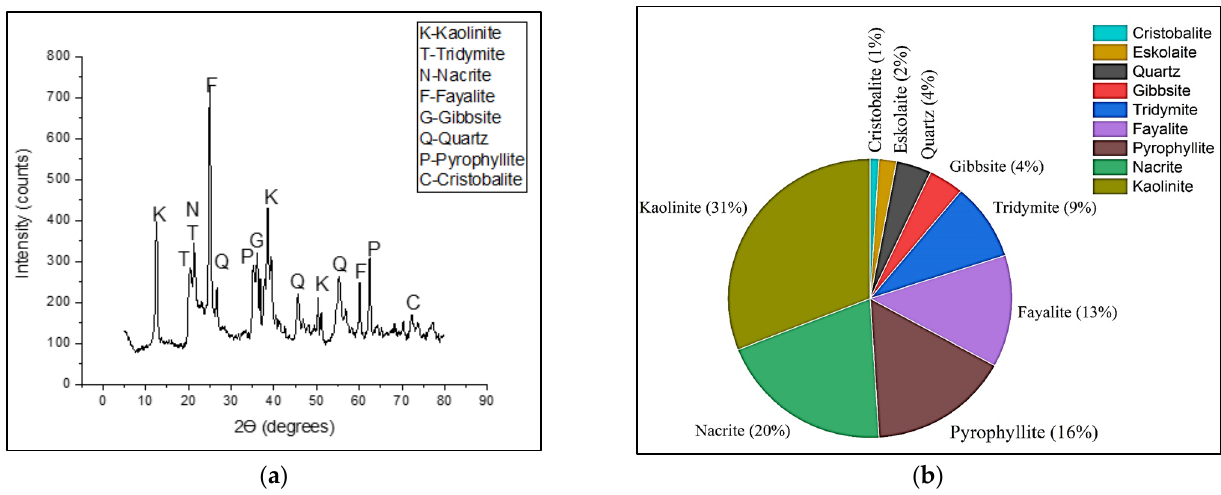
Figure 6. Characterization of minerals and compounds; ( a ) XRD analysis of Alevoor sample; ( b ) quanti fi cation of compounds.